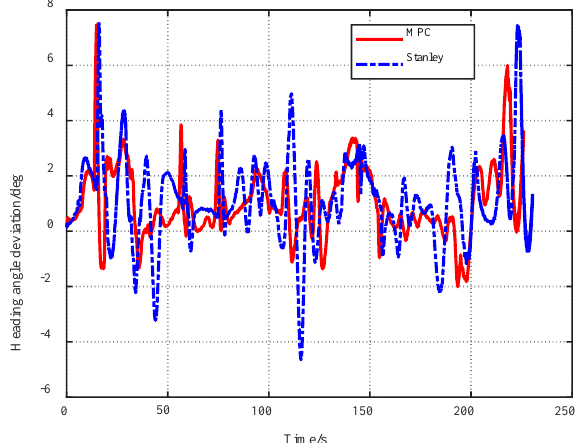
Figure 7. Heading angel deviation of MPC control and Stanley control.